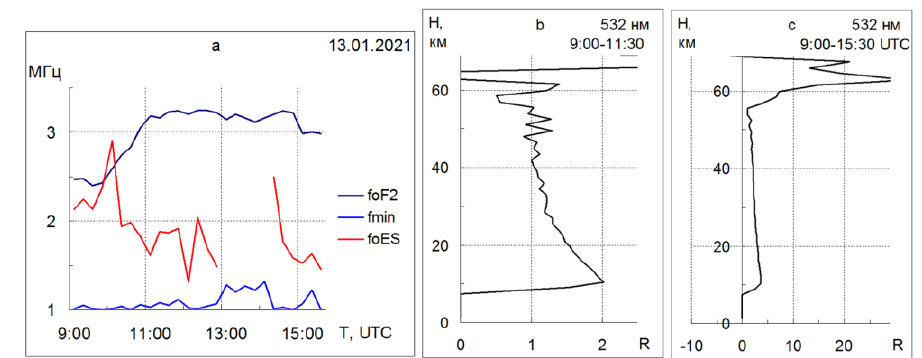
Fig. 3. Values of foF 2 , fmin, foEs ( a ) and profiles of the scattering ratio at the beginning of the sounding session ( b ) and total over the night of 01/13/2021 (c).